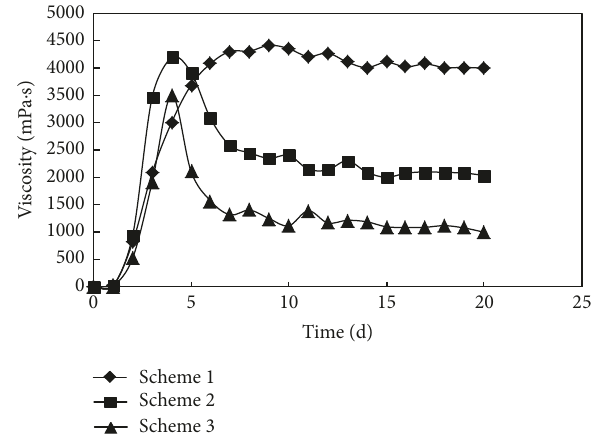
Figure 1: The changing process of viscosity when the concentration of polymer P was